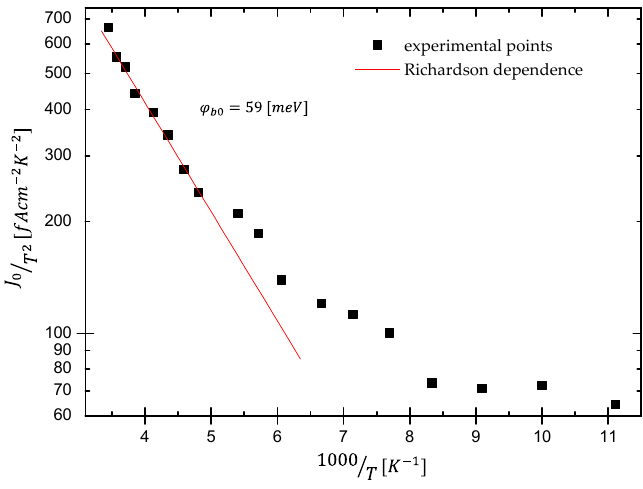
Figure 5. The conventional Richardson’s